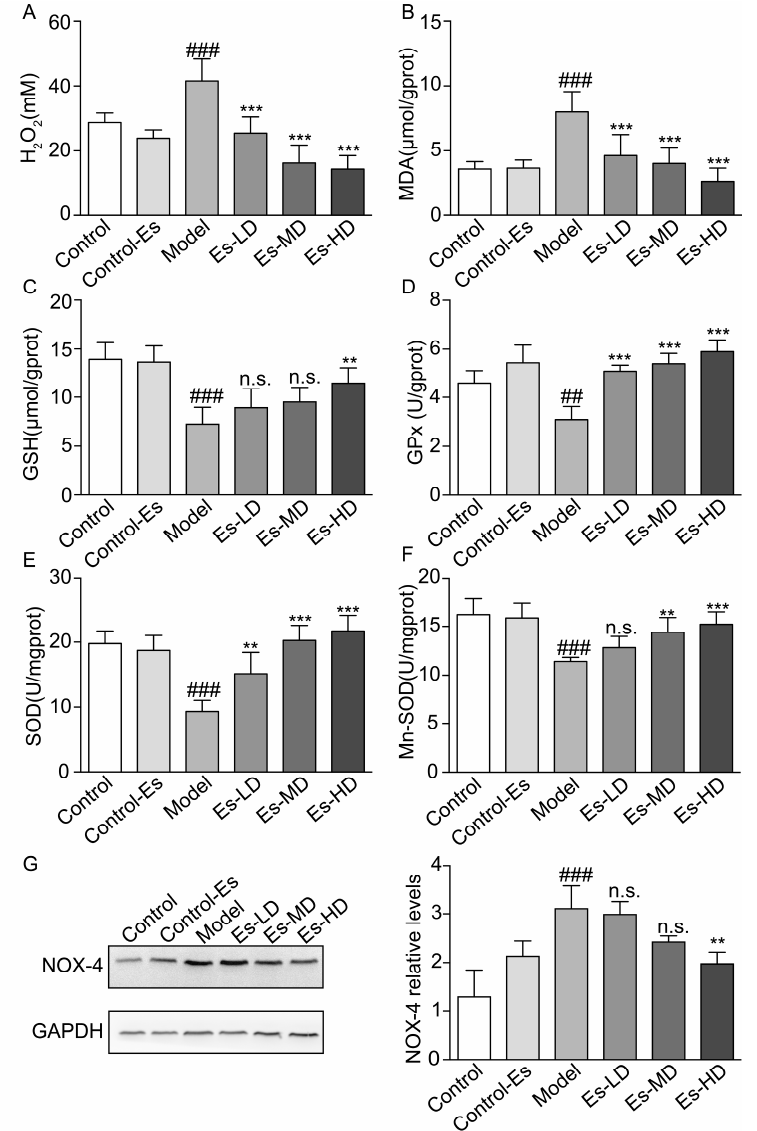
Figure 4. E ff ects of esculetin on oxidative stress levels in HUA model mice. ( A ) Serum H 2 O 2 levels. Vertical bars show data with mean ± SD ( n = 6) ( B ) MDA activity in renal tissue. Vertical bars show data with mean ± SD ( n = 6) ( C ) GSH levels in renal tissue. Vertical bars show data with mean ± SD ( n = 6) ( D ) GPx activity in renal tissue. Vertical bars show data with mean ± SD ( n = 6) ( E ) SOD activity in renal tissue. Vertical bars show data with mean ± SD ( n = 6) ( F ) Mn-SOD activity in renal tissue. Vertical bars show data with mean ± SD ( n = 6). n .s., not significant. ## p < 0.01 and ### p < 0.001 vs. Control. ** p < 0.01 and *** p < 0.001 vs. Model. ( G ). Expression of Nox-4 in the kidney was determined by western blot analysis. Vertical bars show data with mean ± SD ( n = 5). n.s., not significant. ### p < 0.001 vs. Control. ** p < 0.01 vs.